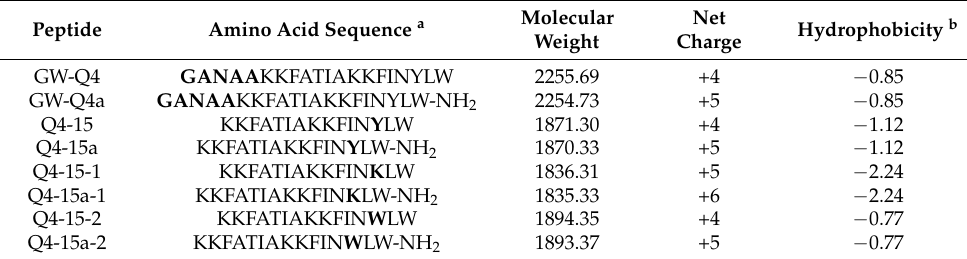
Table 1. Structural parameters and molecular weight of antimicrobial peptides (AMPs) used in the current study.